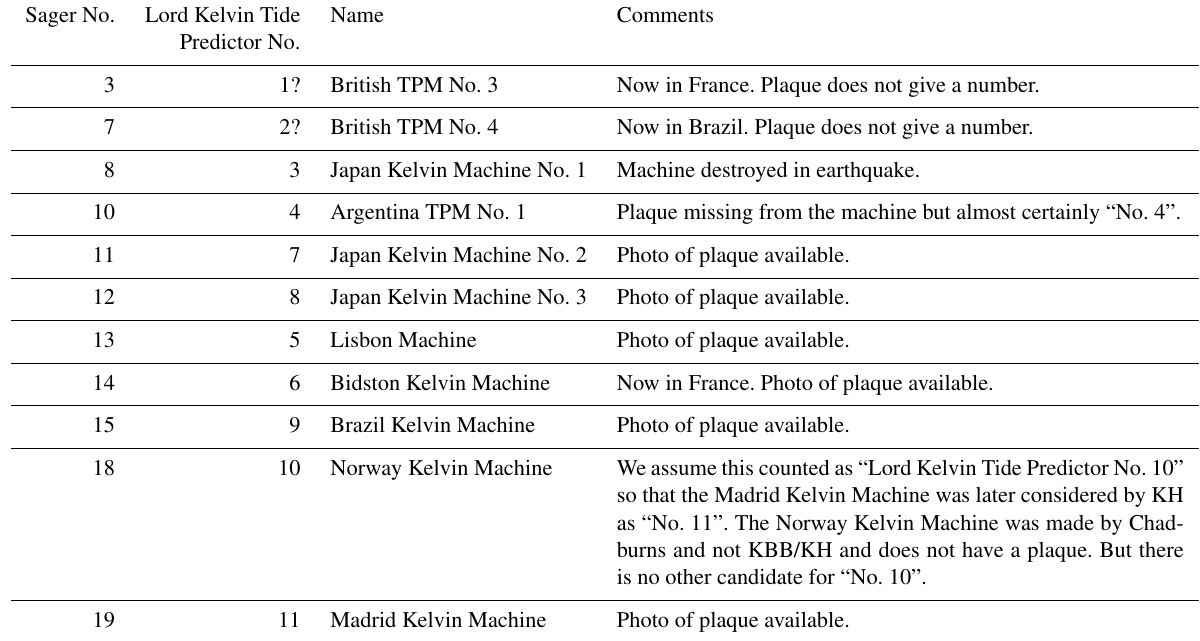
Table 2. Lord Kelvin Tide Predictors. The machines made by the Kelvin companies carried plaques that gave the machine a “Lord Kelvin Tide Predictor” number. This table provides a list of these machines. Sager